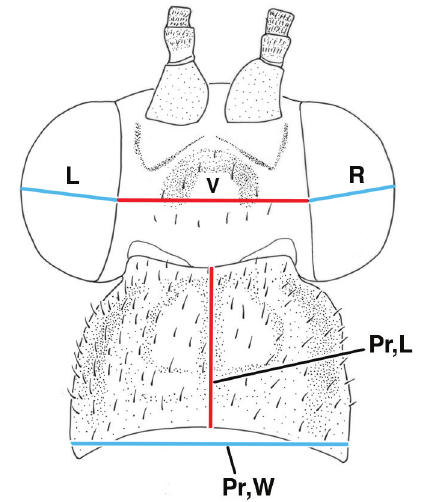
Figure 1. Measurements of head, dorsal. L width of left eye (blue) R width of right eye (blue) Pr,L pro- notal length (red) Pr,W pronotal width (blue) V width of vertex (red).